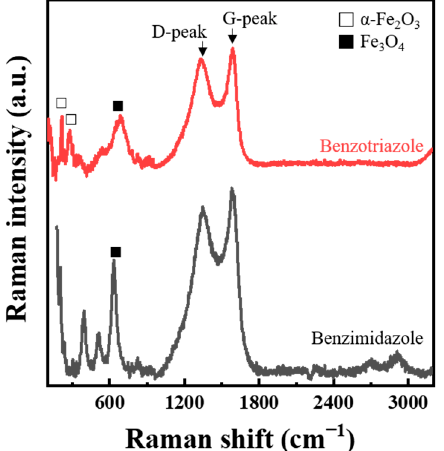
Figure 12. Raman spectra analyzed from the surface of STS specimens after immersion for 168 h in 1 M HCl solution at 298 K with benzimidazole and